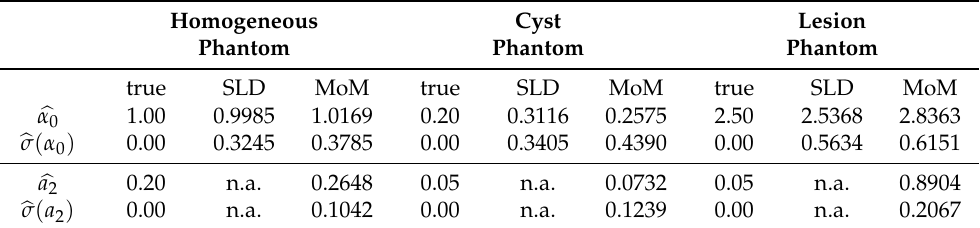
Table 4. Estimation results for all analyzed numerical